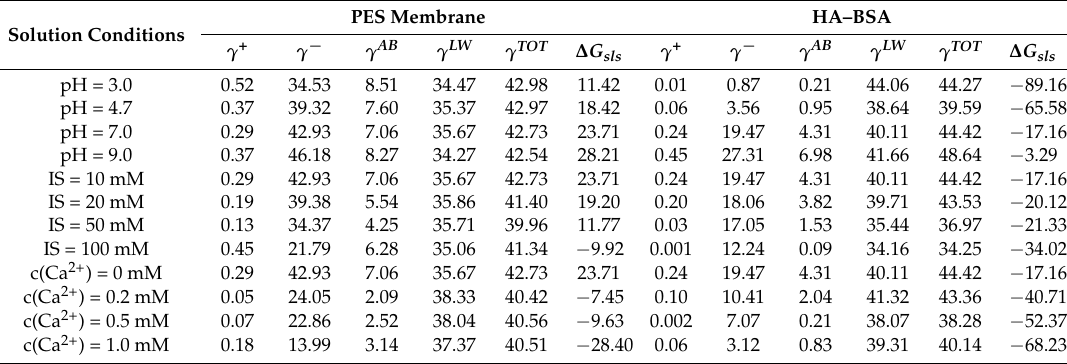
Table 2. Surface tension parameters ( γ ) and interfacial free energy of cohesion, ∆ G sls (mJ/m 2 ) of the PES membrane and HA–BSA mixtures at different solution conditions. Surface tension